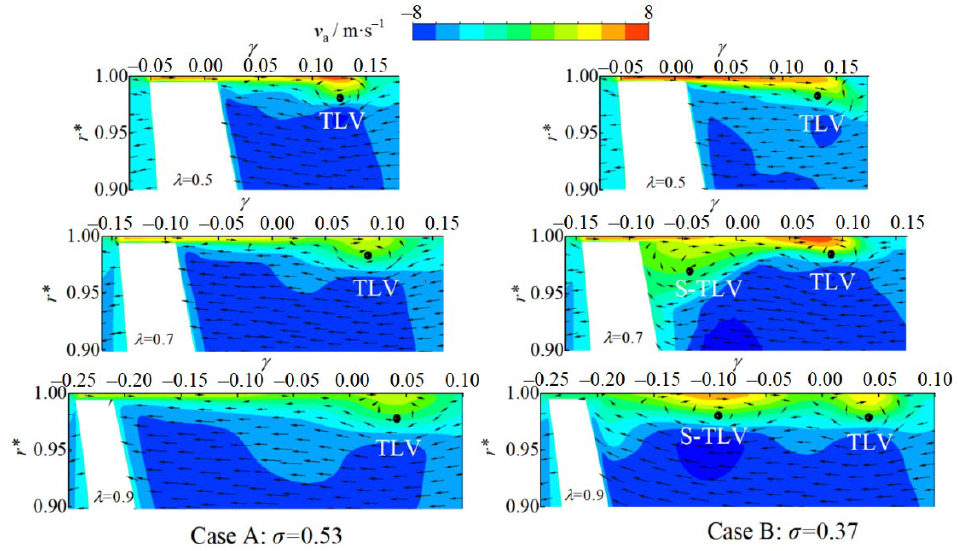
Figure 11. Distributions of axial velocity on three planes. (2) The low-velocity zone M is where the vortices are concentrated. In the r* = 0.98 section, take the curve with a distance of 1mm parallel to the suction side as the sampling line to obtain the circumferential velocity curve, as shown in Figure 12. In case B, the fluid on the suction surface is blocked by the cavity at the front of the blade, and the circumferential v elocity is low in the range of λ = 0.5 to λ = 1.0. Particularly, a local low-velocity zone M emerges , which is located in the position of λ = 0.6–0.7. Com- bined with the pressure distributions in Figure 10a, the re-entrant jet flow is caused by the circumferential pressure difference. Since the cavity bubbles are blocked in front of the blade, the circumferential flow bypasses, which further promotes the formation of the zone M. The zone M is an essential area for the development of the S-TLV, in detail, where the axial leakage velocity is high, and the formed shear vortices are gradually accumu- lated, which appear as the prominent source of the S-TLV. Figure 12. Circumferential velocity distributions and low velocity zone M. As observed from Figure 13, in the sections of λ = 0.7 and λ = 0.9, the circumferential velocity of the S-TLV area of case B is lower than that of the corresponding position of case A.